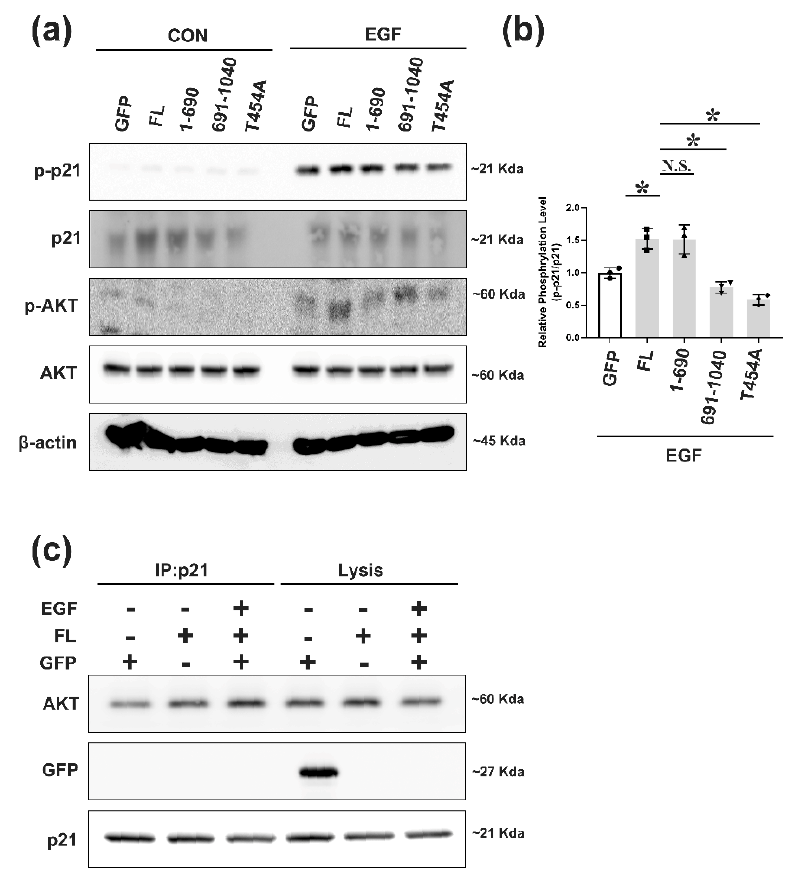
Figure 4. EGF is one upstream ligand for regulating AKT/ δ -catenin/p21 signaling. ( a ) Rv-1 cells were transfected with the respective plasmid followed by serum starvation and treated with EGF 100 ng/mL for 5 min. This experiment was repeated independently three times. ( b ) The quan- titation of p-p21/p21 in ( a , c ). Immunoprecipitation with the anti-p21 waf antibody, followed by immunoblotting with the anti-AKT antibody using lysate obtained from transfected Rv-1 cells after serum starvation treatment with EGF 100 ng/mL for 5 min. All p -values were determined with unpaired Student’s t -test: *, p <